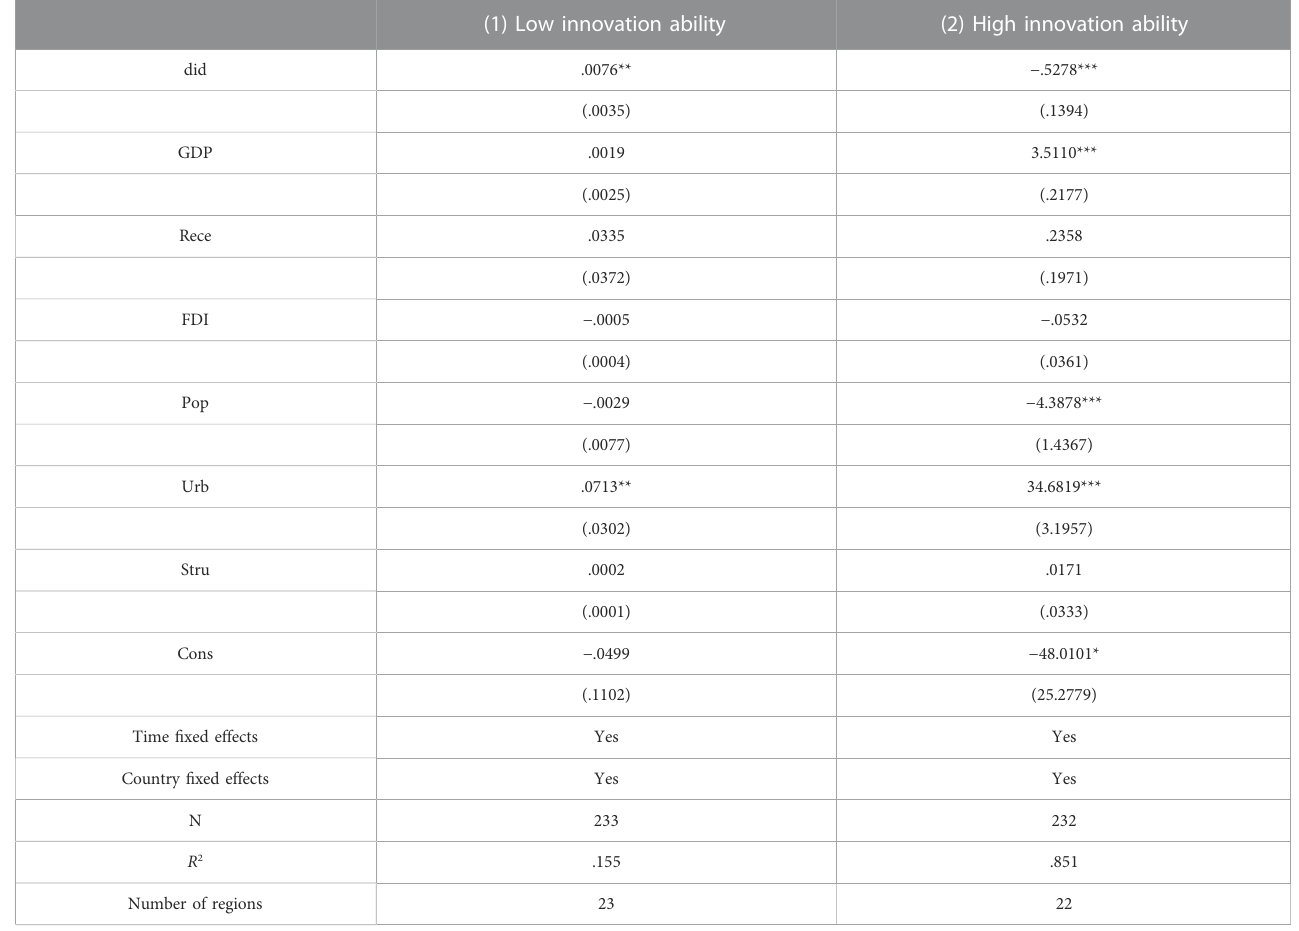
TABLE 7 Heterogeneity test of innovation ability. (1) Low innovation ability (2) High innovation